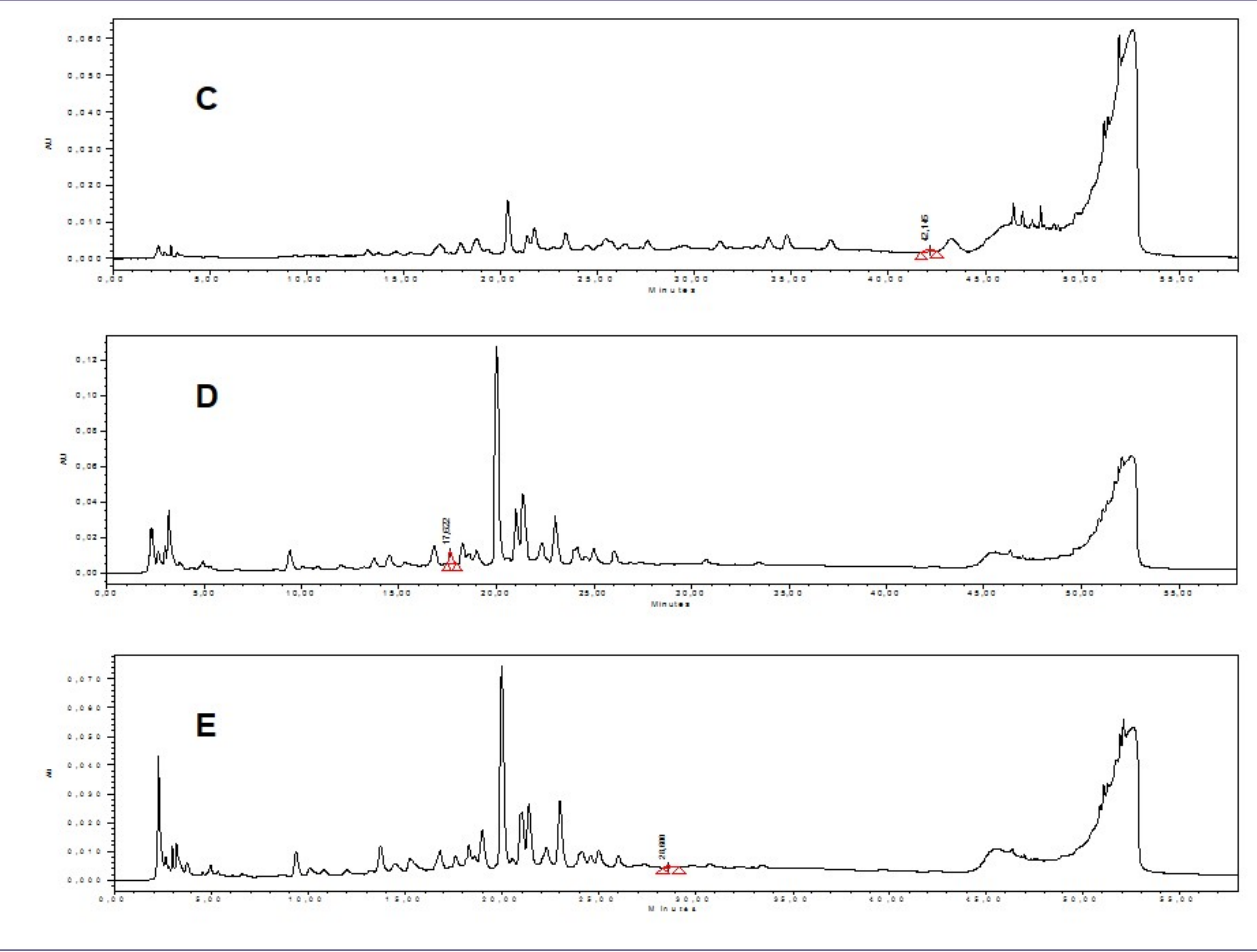
Table 3. GC ‐ MS analysis of Neurada procumbens n ‐ hexane fraction.